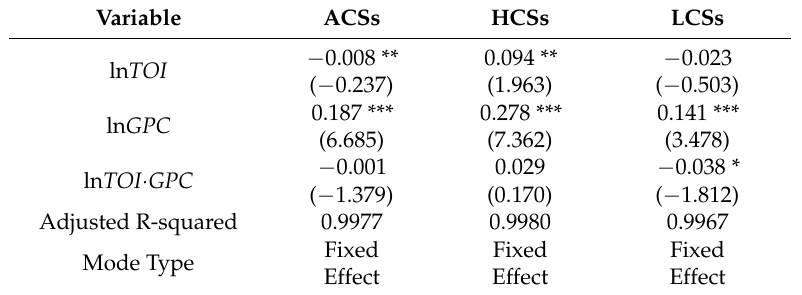
Table 4. Regression analysis of cross term between trade openness and per capita